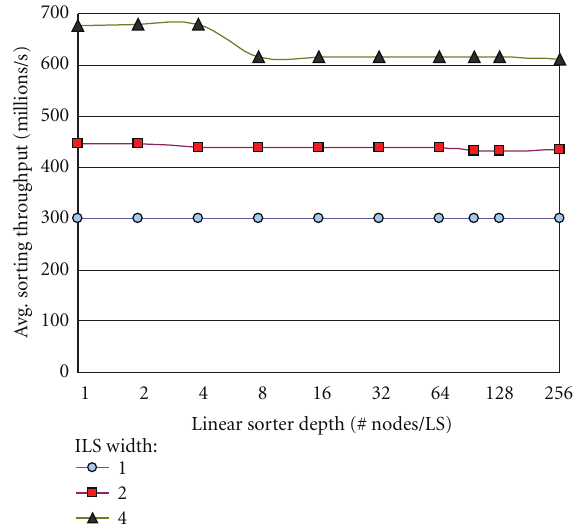
Figure 12: Improved normalized throughput for ILS system with delayed contention bu ff ering.